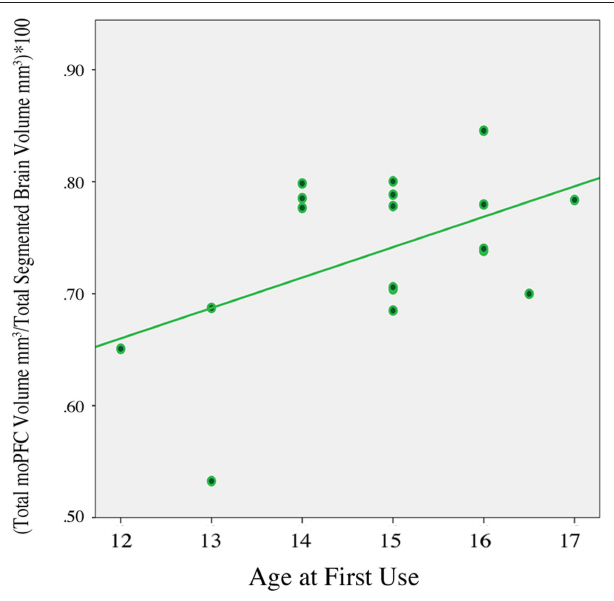
FiguRE 2 | Coronal sections from CA subject with (A) cortical (red) and white matter (yellow) surfaces outlined, (B) ROI in entire orbital prefrontal cortical region, (C) ROI in loPFC, and (D) ROI in moPFC. CA, cannabis abusing; ROI, region of interest; loPFC, lateral orbital prefrontal cortex; moPFC, medial orbital prefrontal cortex. Yellow ROI line was thickened for visibility in (B–D) .